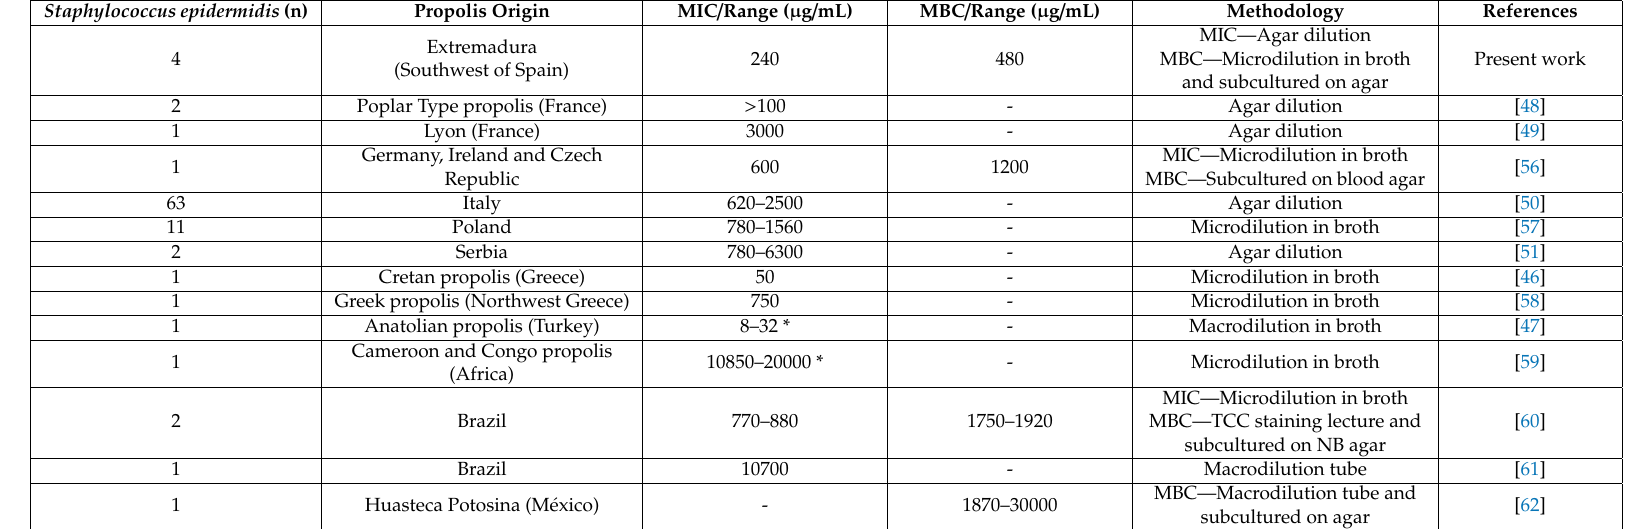
Table 4. Antibacterial activity (MIC and MBC or range) of ethanolic extract of propolis from di ff erent geographical origins against Staphylococcus epidermidis strains. Staphylococcus epidermidis